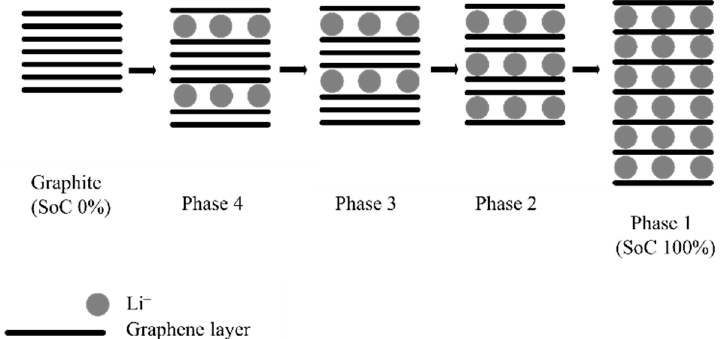
Figure 2. Graphite phases from discharged to fully charged graphite electrode (from [24]).